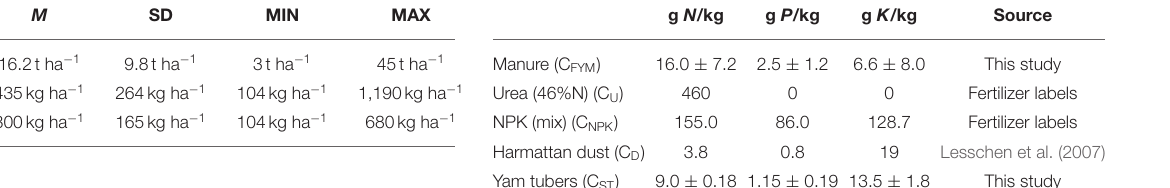
TABLE 4 | Quantities of applied fertilizer as reported by famers. Fertilizer